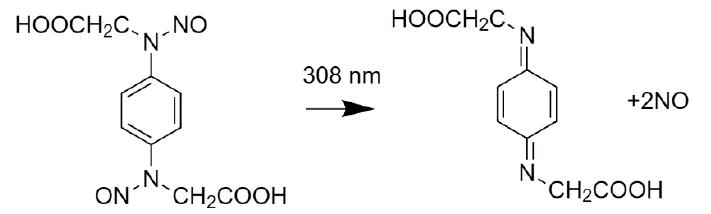
Figure 3. The photocage molecule used in [33]. On the left is the photocaged NO and the corresponding de-caged molecules after laser photoexcitation at 308 nm are on the right [74].